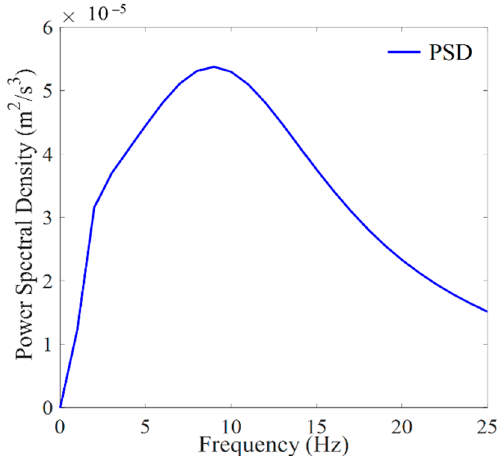
Figure 5. Clough–Penzien spectrum.